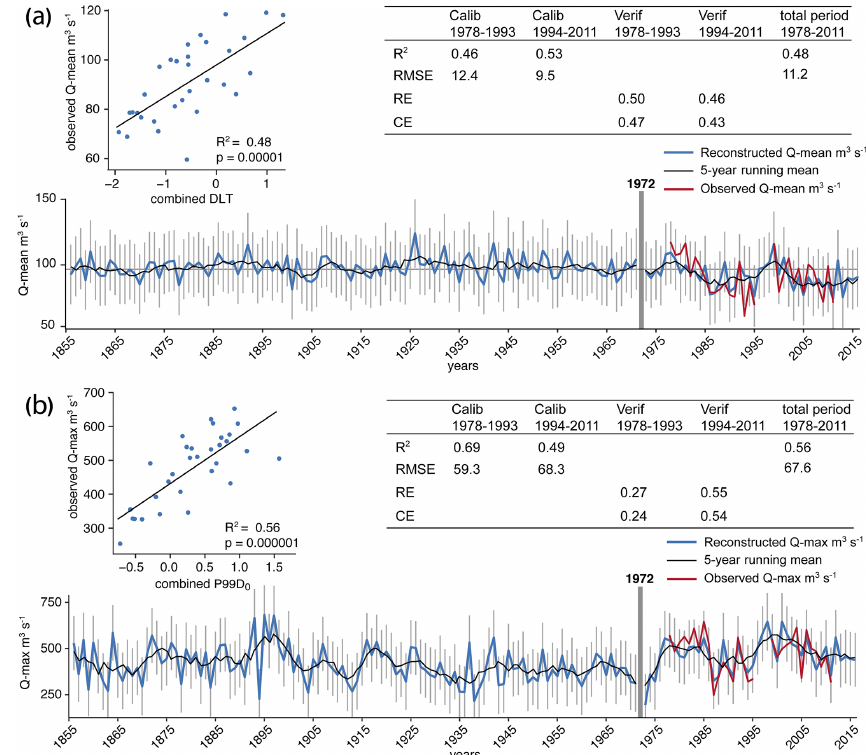
Figure 8. Naskaupi River (a) Q -mean and (b) Q -max reconstructed from combined DLT (without the NAS-1 1978-2016 period) and P99D 0 series respectively, for the 1856–2016 period (blue line), with a 5-year moving average (black line). Error bars represent the 95% confidence interval. Observed Q -mean and Q -max are also shown for the 1978–2011 period (red line).